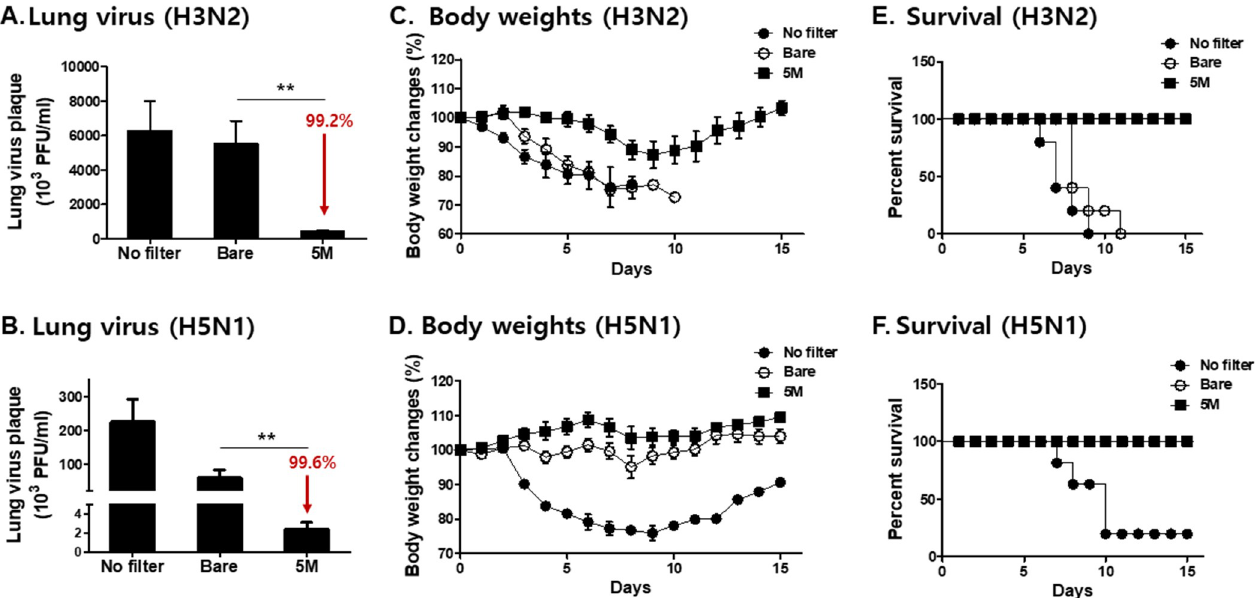
Fig 6. Virus infectivity study in mice using viruses passing through the filters. Mask filters coated with 5 M of salt and aerosolized influenza viruses (A/ H3N2, 2mg/ml, A/H5N1, 2mg/ml) were passed through the filters. Passed viruses were harvested to infect mice, and virus titers in the lung, bodyweight changes, and survival were assessed. Lung virus titers (A and B, n = 6, mean ± SEM, �� P < 0.01), bodyweight changes (C and D, n = 5), and survival rates (E and F, n = 5).